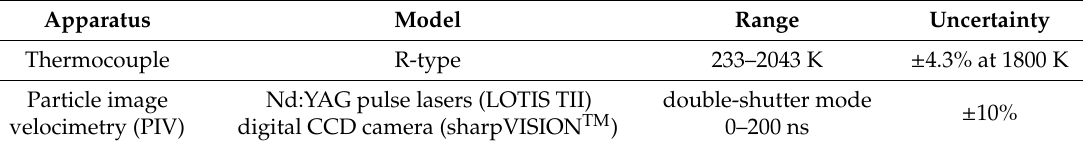
Table 1. The uncertainties for major pieces of apparatus. Nd:YAG—neodymium-doped yttrium aluminum garnet; CCD—charge-coupled